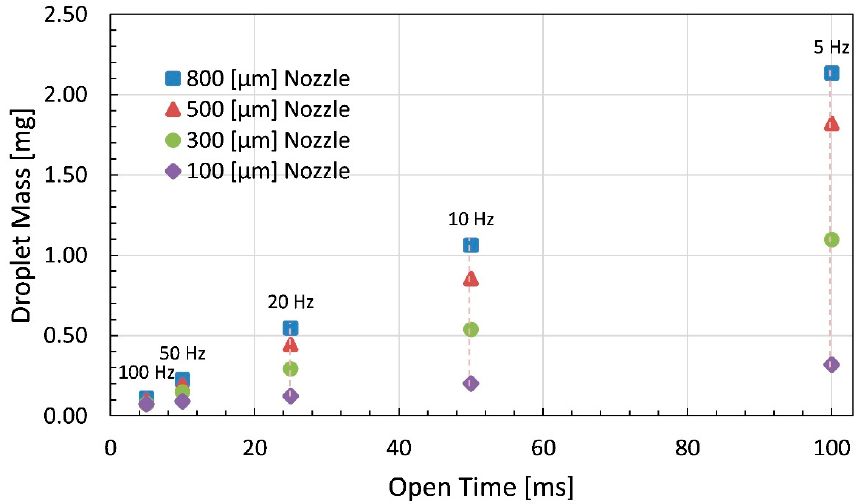
Figure 14. Droplet mass of dispensed droplets using 12,480 mPa·s liquid silicone by Brookfield plotted against open time with respect to varying frequency and nozzle diameter.